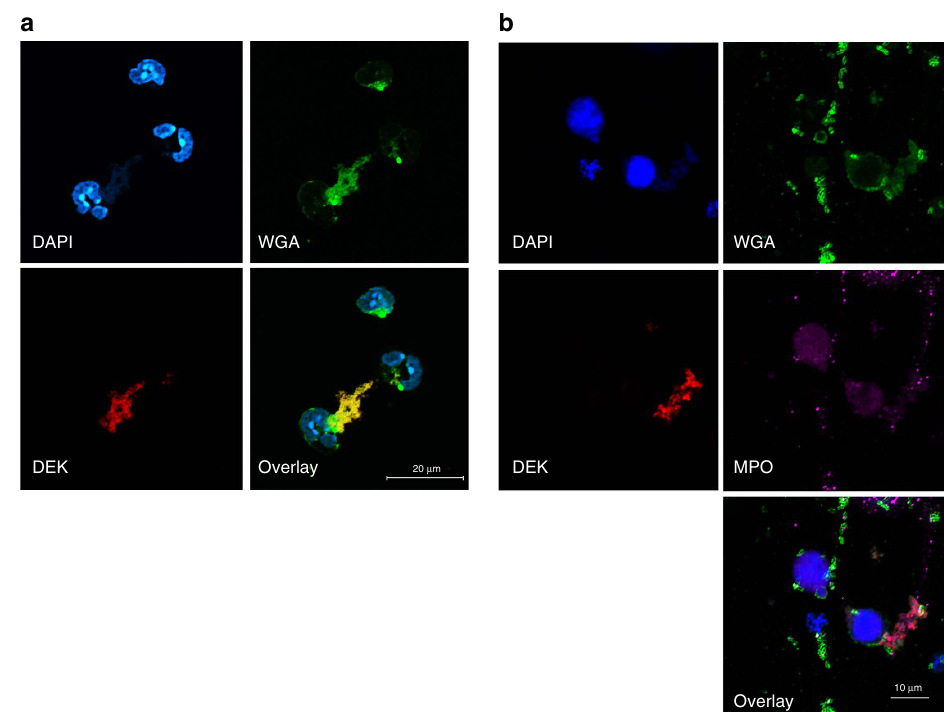
Figure 5 | Extracellular recombinant DEK does not enter the cell but restores NET formation in Dek -KO neutrophils. Dek -KO ( n ¼ 3) BM neutrophils were treated with recombinant DEK prior to PMA stimulation. ( a ) Cells were fixed 2-3h after PMA treatment, and then permeabilized and stained for DEK (red) and wheat germ agglutinin (WGA), a membrane marker. DEK is detected outside of the cell in the NETs ( (cid:3) 60 magnification, scale bar 20 m m, Nikon Confocal). ( b ) Cells were also stained for the NETmarker myeloperoxidase (MPO, purple), DEK (red) and WGA (green). DEK is detected outside of the cell in NETs ( (cid:3) 60 magnification, scale bar 10 m m, Nikon Confocal). Images are representative of three different fields from at least three independent